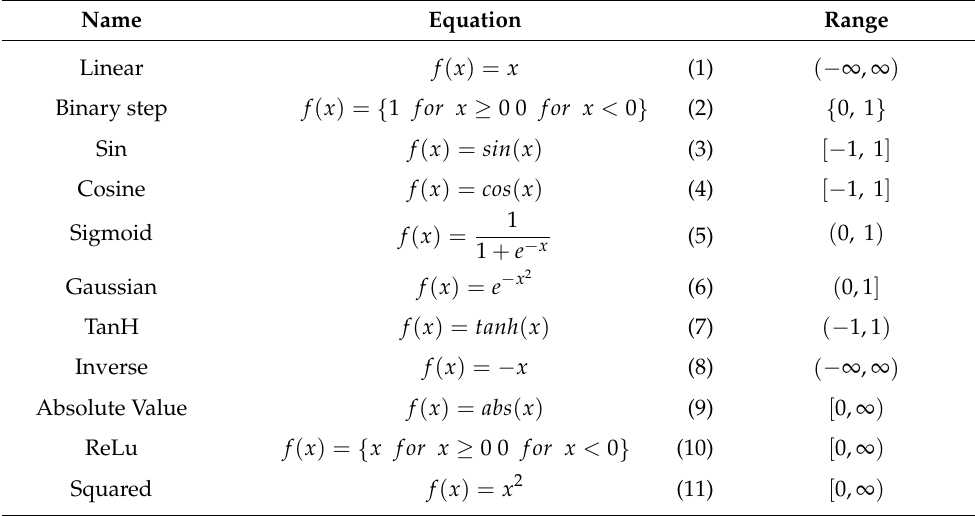
Table 1. Summary of the pool of activation functions that the weight agnostic neural network samples from.